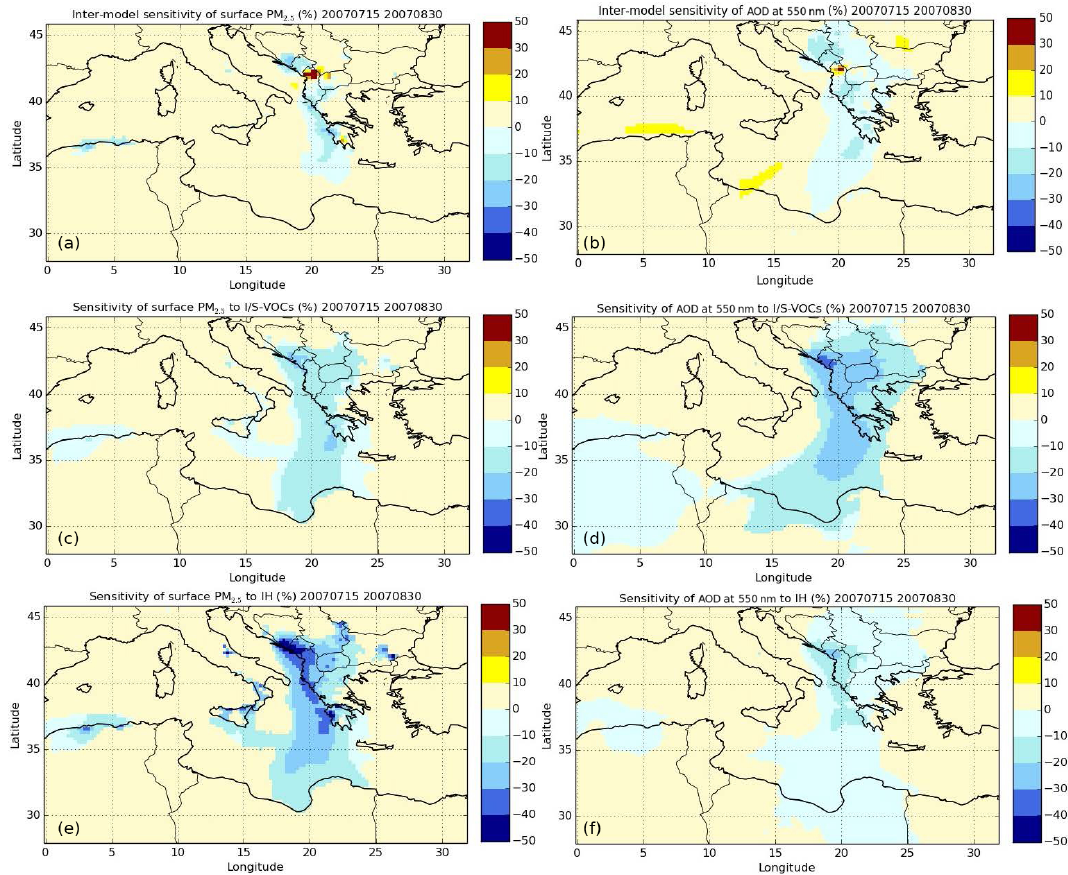
Figure 10. Sensitivity of surface PM 2 . 5 concentrations (a, c, e) and AOD at 550nm (b, d, f) to the CTM used ( CHIMERE-ref or Poly-ref , upper panels), the modeling of I/S-VOC emissions ( Poly-noI/S-VOCs or Poly-ref , middle panels) and the injection height (IH) ( Poly-3km or Poly-ref , lower panels) during the summer of 2007 (15 July to 30 August). Simulation Poly-ref is used in all panels to estimate the relative